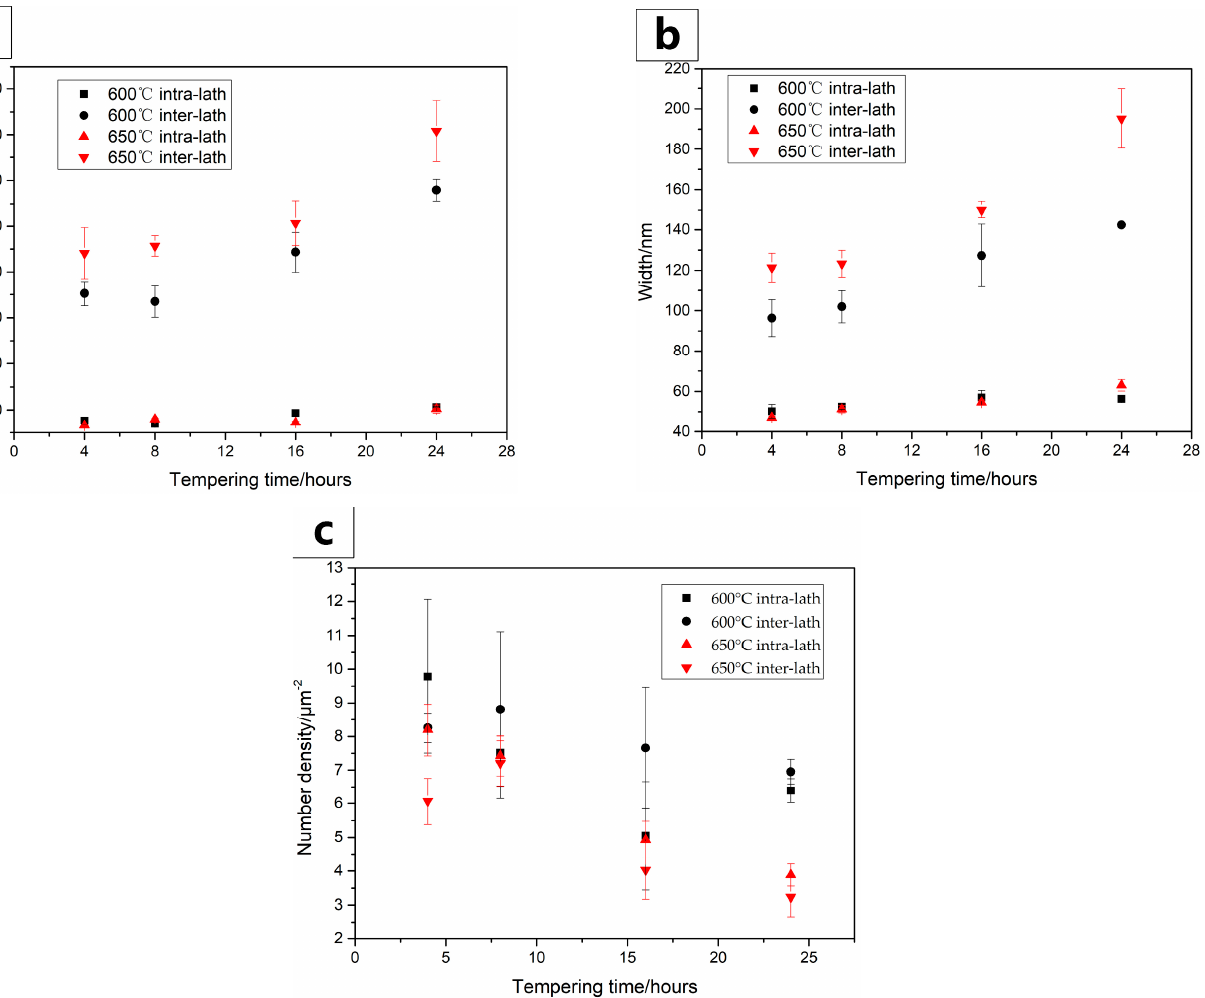
Figure 4. The average ( a ) length ( b ) width and ( c ) number density variations for carbides in Dievar steel in different tempering conditions (SEM observations). steel in different tempering conditions (SEM Table 3. Lath size variation in different tempering conditions.